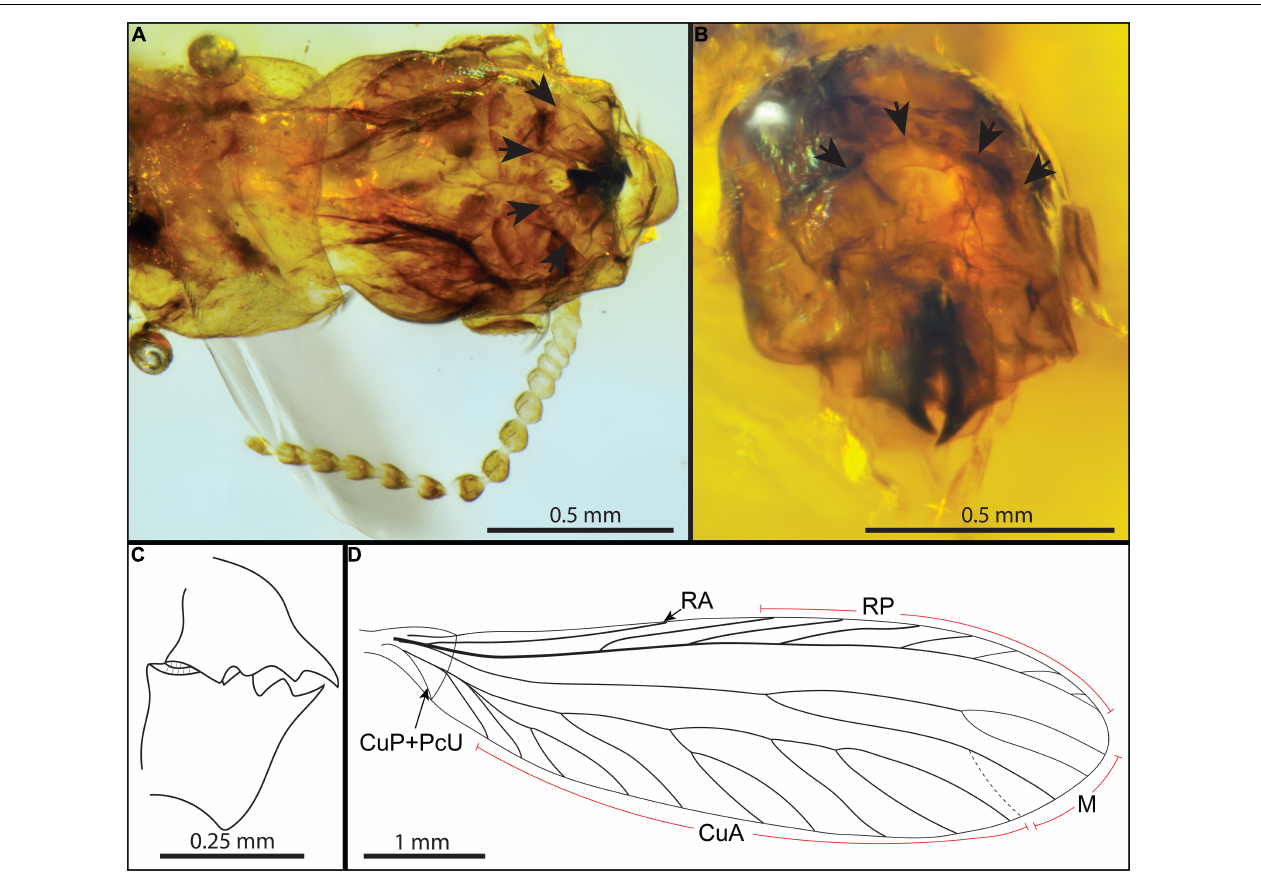
FIGURE 2 | Detailed views and interpretative drawings of morphological features of the valkyrie Valkyritermes inopinatus gen. et sp. nov. (A) Microphotography of head in dorsal view, arrows: flange. (B) Microphotography of head in face view, arrows: flange. (C) Line drawing of mandibles. (D) Interpretative line drawing of